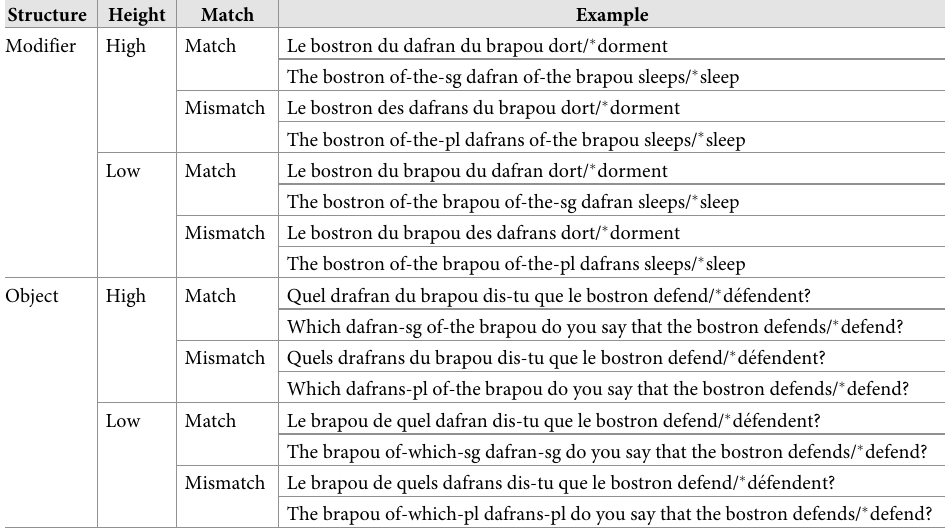
Table 1. Examples of items in the different experimental conditions formed by the crossing of structure, height, number match and grammaticality in Experiment 1. Structure